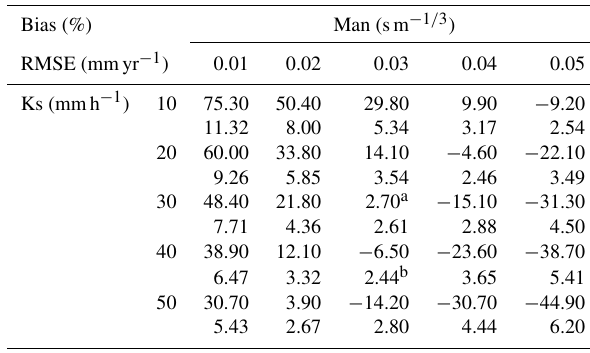
Table 7. Percent bias and RMSE on annual discharge over 2011– 2015 for 25 sets of channels Ks and Man